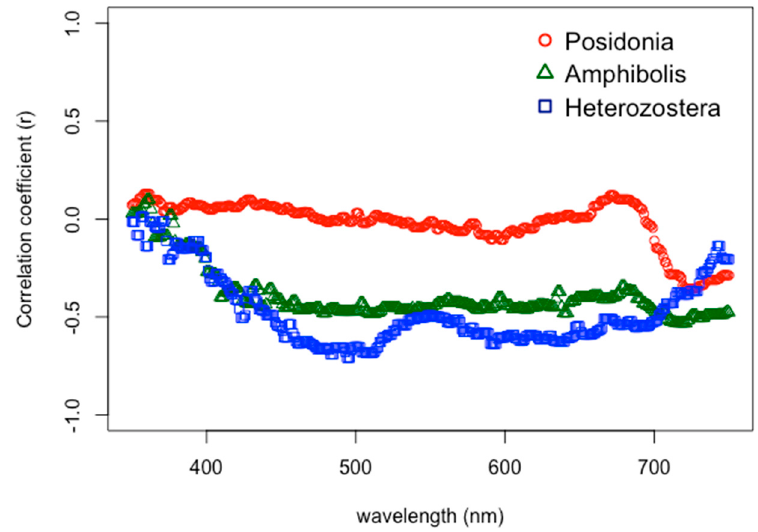
Figure 8. Correlation coefficients between natural growing depths of seagrasses and different derivative reflectance profiles.